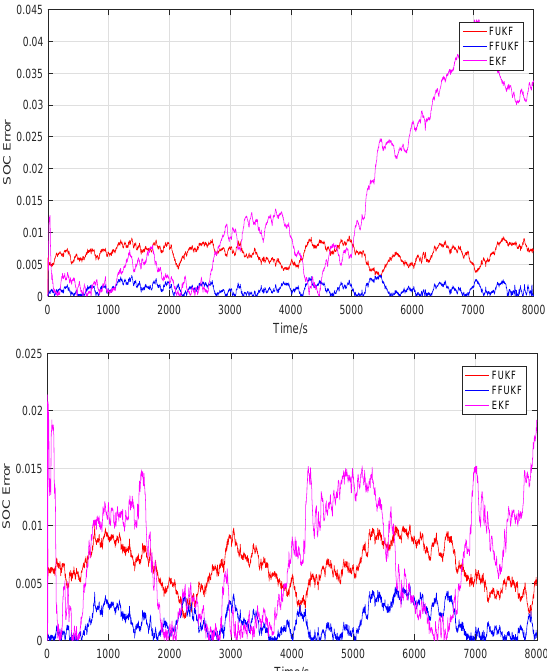
Figure 11. The SOC estimation error curves under BJDST and FUDS at 25 ◦